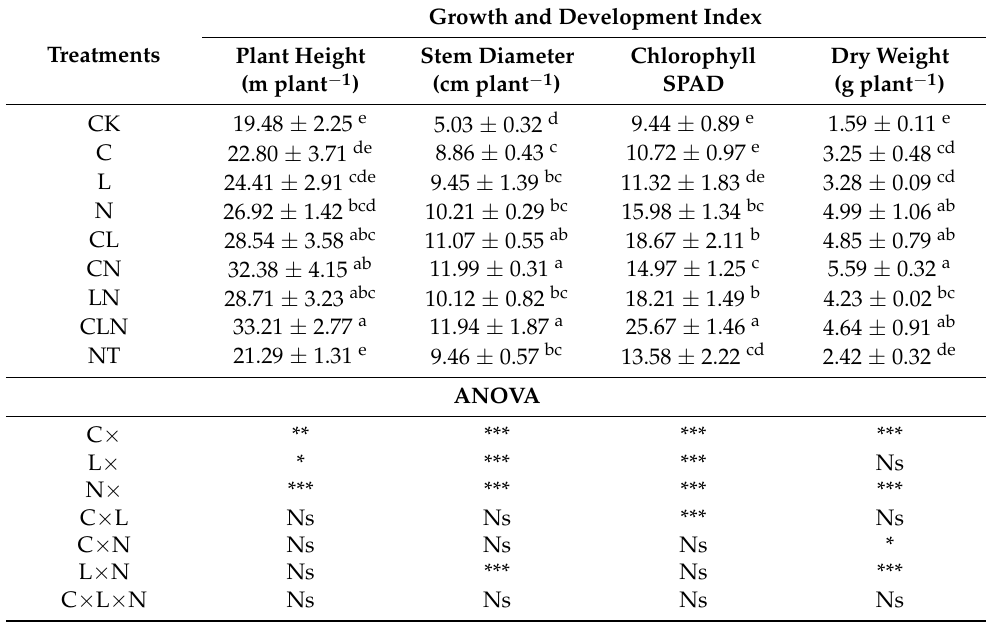
Table 3. Growth analysis of stem and leaf in seedling stage in